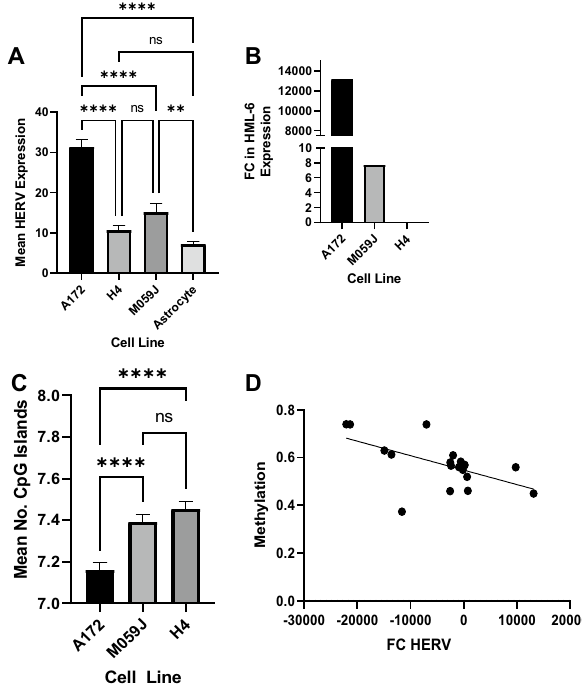
Figure 2. Mean HERV expression was highest in the A172 cell line ( A ), and HML6 is uniquely overexpressed in the A172 and M059J cell lines. However, HML6 expression was an order of magnitude higher in A172 relative to expression in M059J ( B ). Mean number of methylation sites, expressed as CpG islands, was lowest in the A172 cell line ( C ). Correspondingly, we found a significant inverse correlation between methylation (beta value) and log2 fold change (log2FC) in HERV expression across all investigated cell lines ( D ).